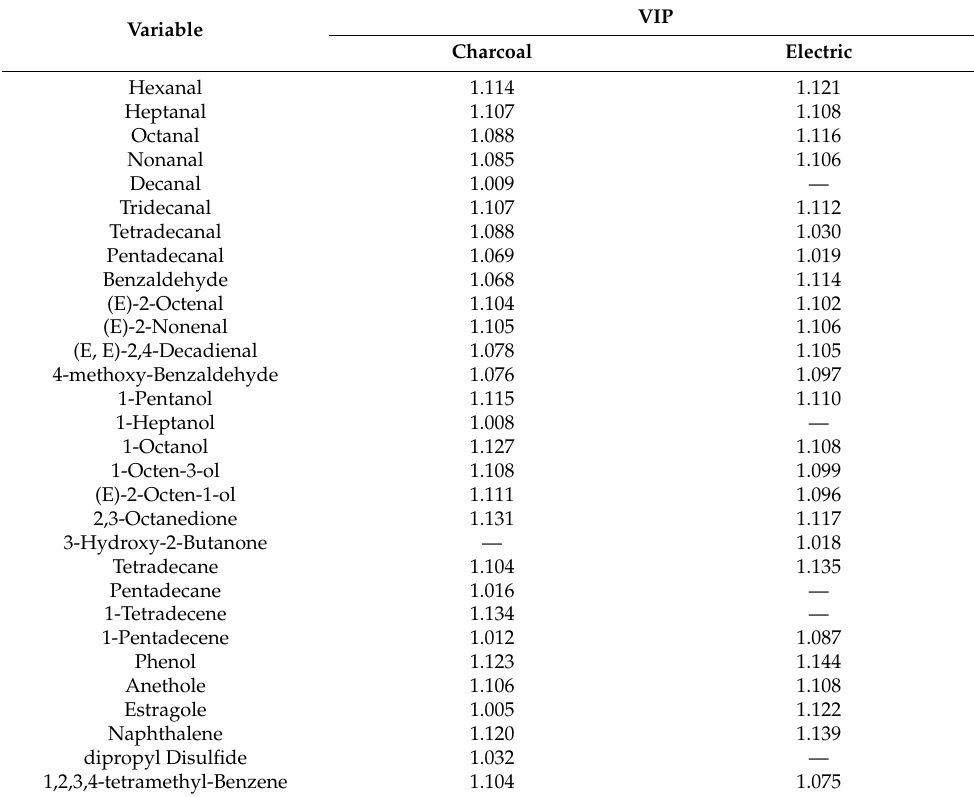
Table 4. The volatile compounds with VIP >1 (markers) of tamarix lamb roasted by charcoal or electric.